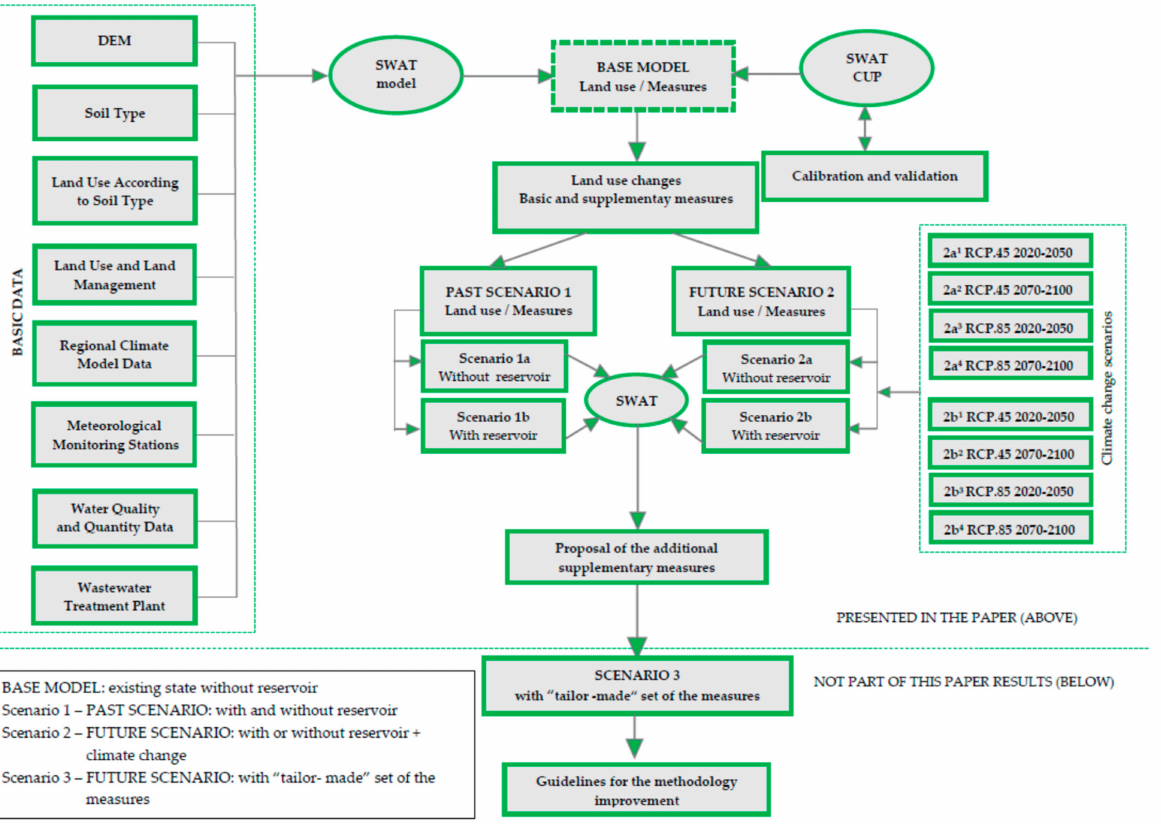
Figure 4. Scheme of the SWAT integrated water quality management model.